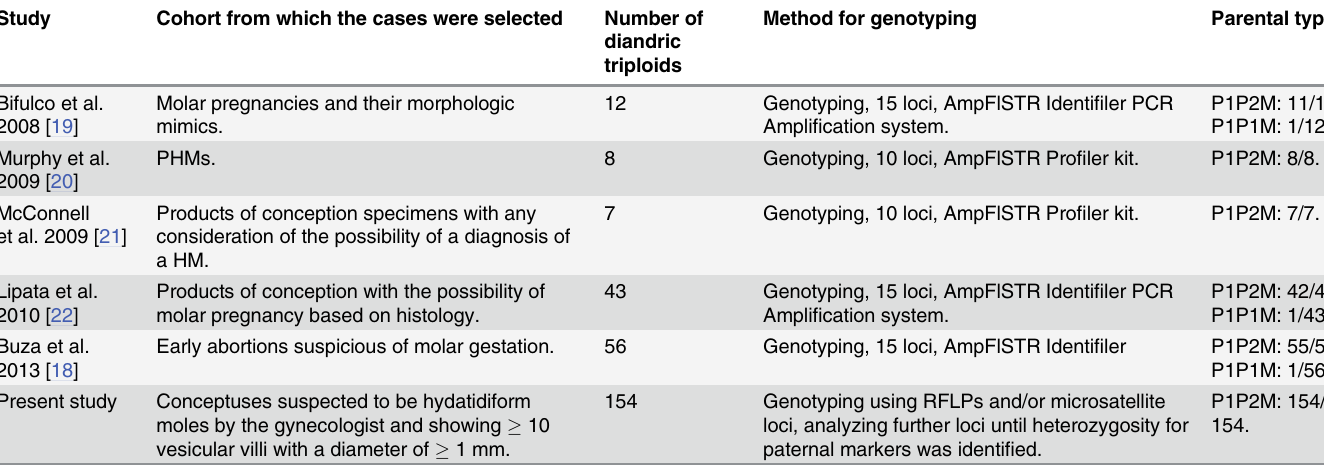
Table 2. Parental types in triploid conceptuses with molar phenotype. Study Cohort from which the cases were selected